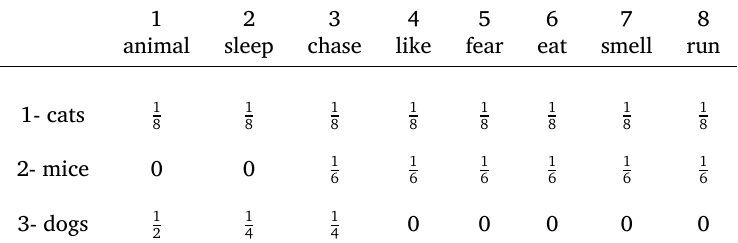
Table 6: The normalised co-occurrence matrix built from the example corpus with the co-occurrence window taken to be occurrence within the same sentence 1 2 3 4 5 8 animal sleep chase like fear eat smell run 1-